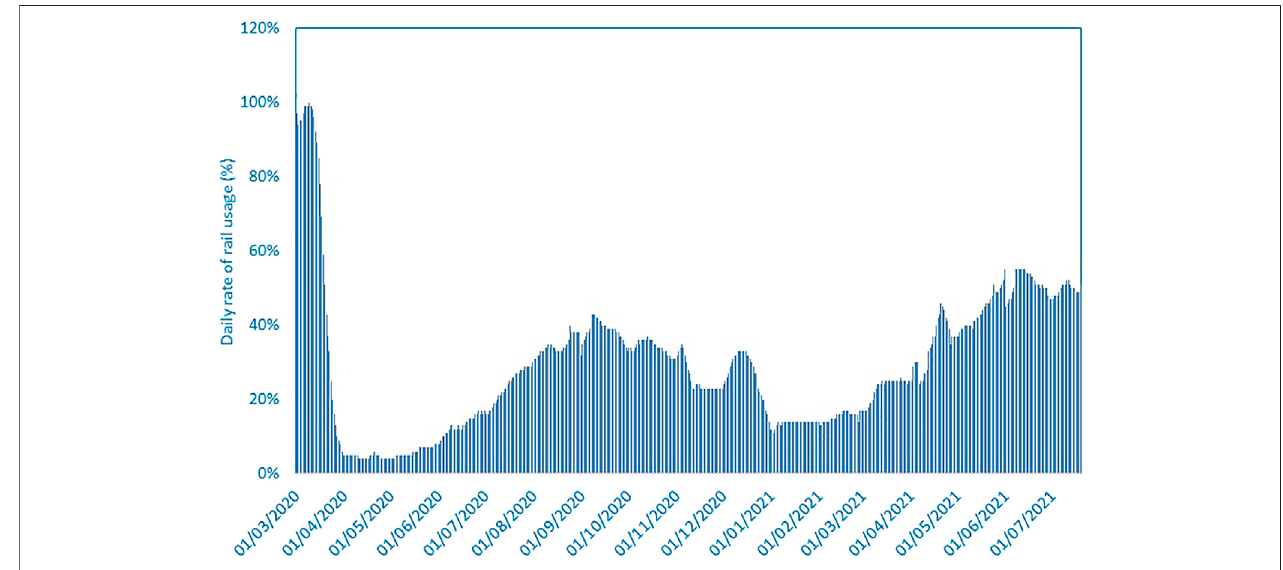
FIGURE1| Percentage ofdaily rateofnationalrailusageinthe UnitedKingdomderived fromtheopen databyUnited KingdomDepartment for Transport(source: https://www.gov.uk/government/statistics/transport-use-during-the-coronavirus-covid-19-pandemic).